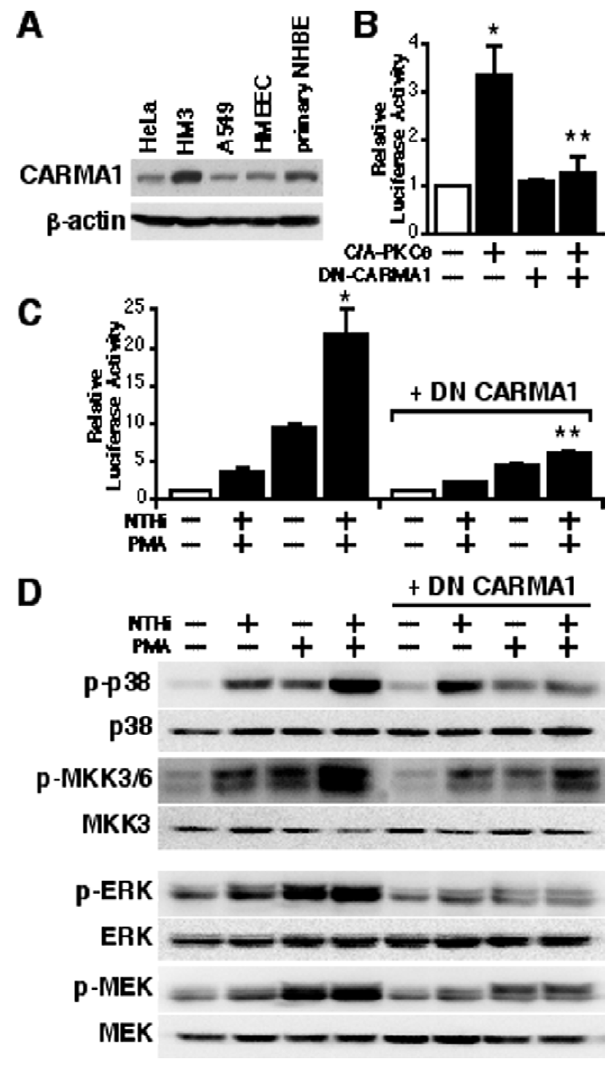
Figure 7. CARMA1 acts downstream of PKC h in mediating PMA- induced synergistic enhancement of TLR-TRAF6-dependent MUC5AC expression. ( A ) CARMA1 was expressed in a variety of epithelial cells, such as in human cervix HeLa, colon HM3, airway A549, middle ear HMEEC-1 and primary bronchial epithelial NHBE cells, as assessed by WB using antibody against CARMA1. ( B ) Overexpression of a DN mutant form of CARMA1 attenuated C/A-PKC h -induced MUC5AC expression. Cells were transfeced with 0.3 m g of C/A PKC h with or without 0.8 m g of DN-CARMA1. Relative luciferase activity of MUC5AC was measured from the cell lysate. Values are the means 6 S.D. (n=3). *p , 0.05 vs. control; **p , 0.05 vs. C/A PKC h transfected cells. ( C ) The synergistic induction of MUC5AC transcription by NTHi and PMA